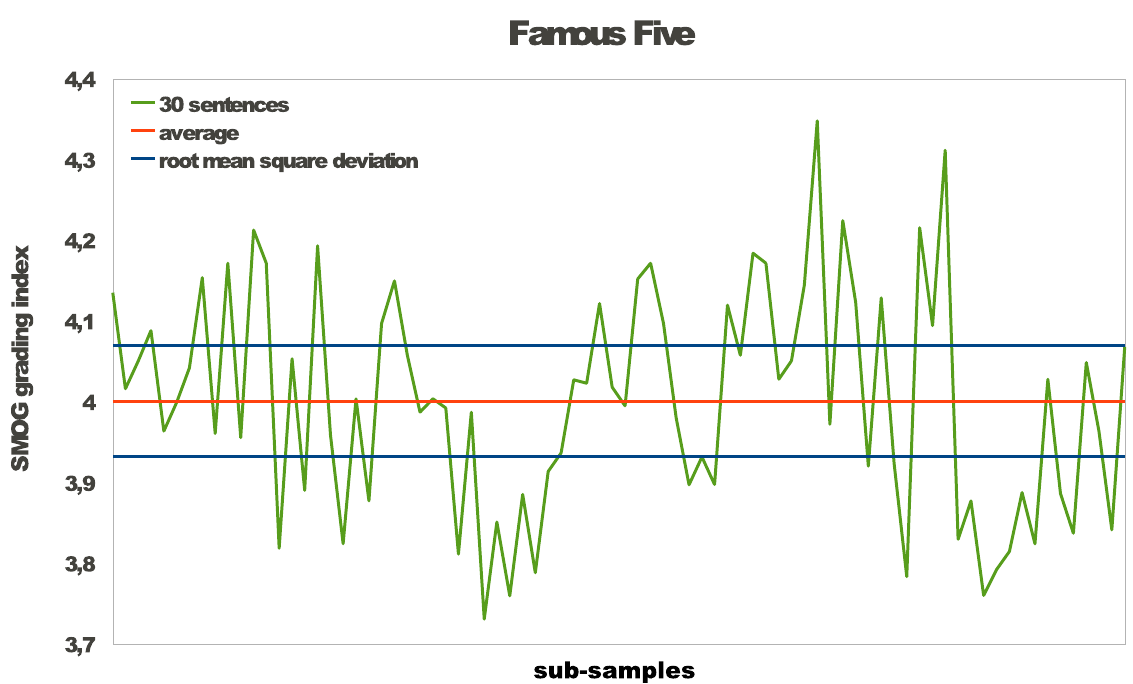
Figure 1. Readability over sub-samples of a longer text.